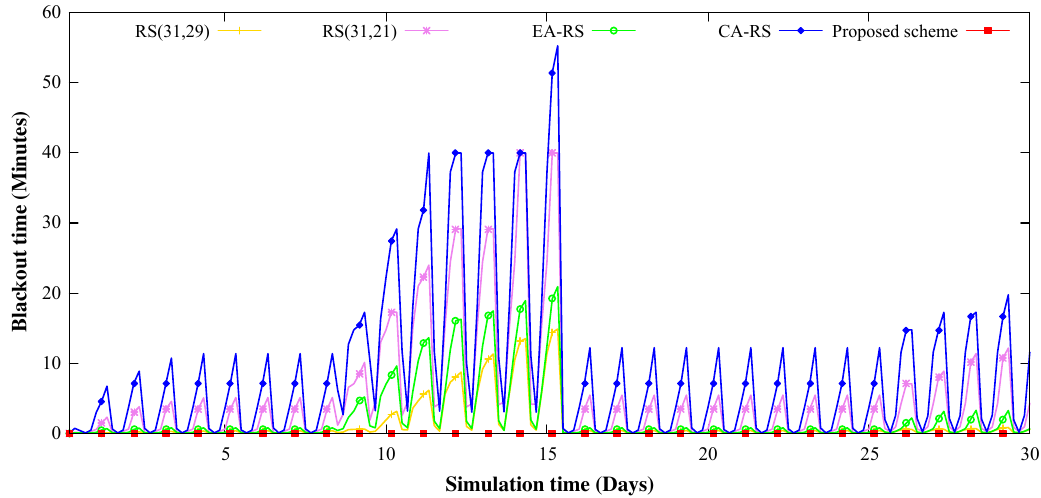
Figure 9. Change in the blackout times, according to simulation time, for 150 nodes and 0.15 BER (9th ∼ 15th day: rainy, 26th ∼ 30th day: cloudy; others: sunny).